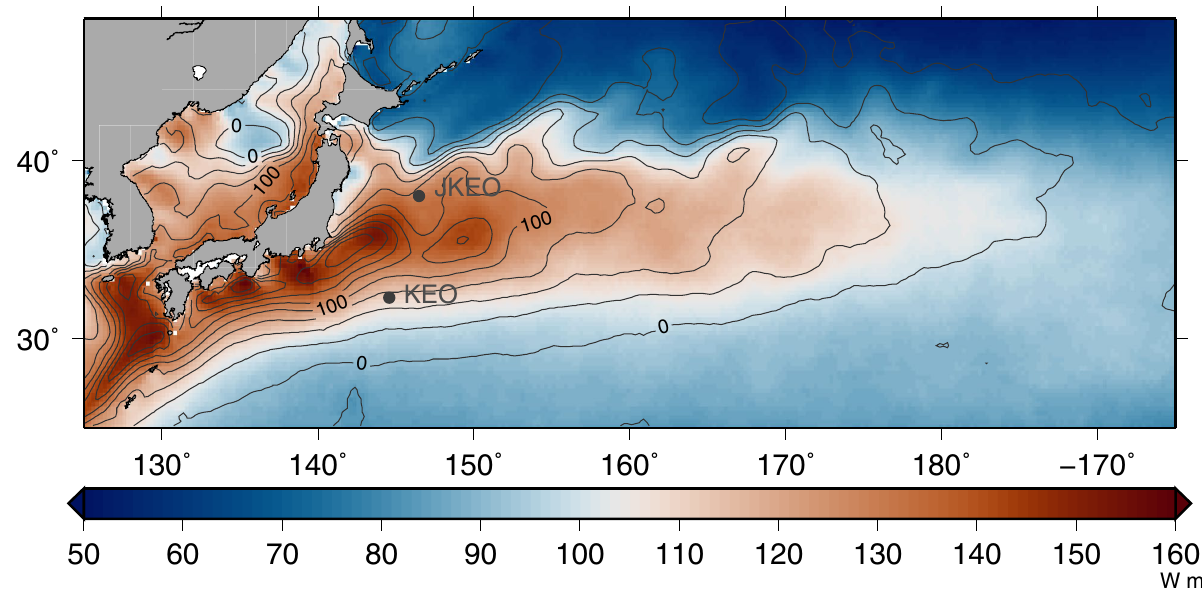
Figure 1. Location of the JKEO and KEO buoys in the Kuroshio Extension region. Colours show the magnitude of variation of the net heat flux at the synoptic time scale, defined as the standard deviation of high- pass-filtered satellite-derived air–sea heat flux (J-OFURO3 daily mean data) 8 . The high-pass filter was based on 60 days running mean. Contours represent the long-term mean of the J-OFURO3 surface net heat flux (1988–2017). Positive values imply heat flux from the ocean to the atmosphere. Units are in W/m 2 . The Generic Mapping Tools (version 5, https ://www.gener ic-mappi ng-tools .org) was used to create this